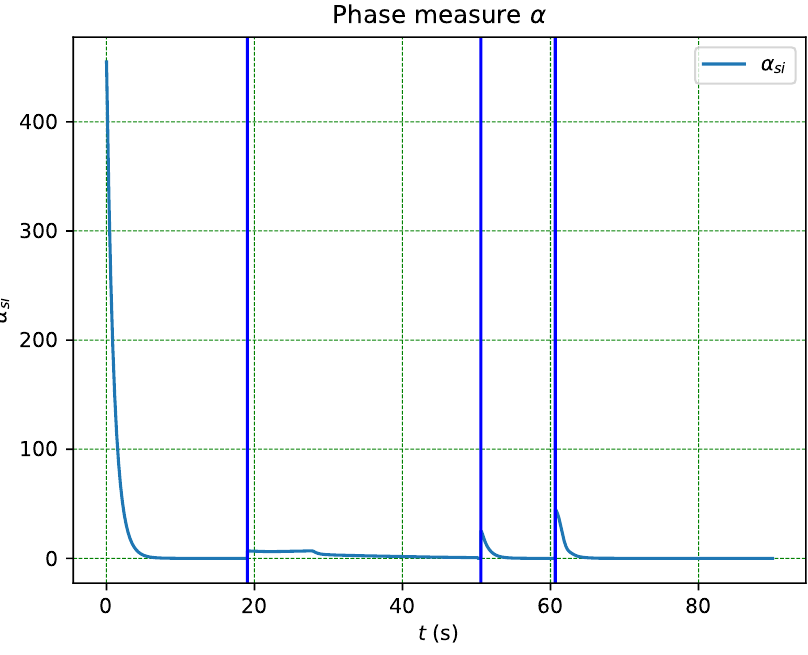
Figure 15. Measure given by each